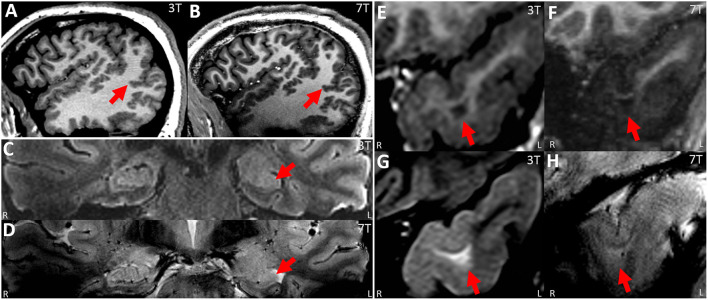
(A,B) Paired 3T−7T Images from a patient with extensive PMG in the right temporo-parieto-occipital region, showing similar lesion presence, improved lesion conspicuity and improved boundary (especially at the posterior part of the lesion, as shown by arrow) as assessed by the neuroradiologist team. (A) Sagittal image from T1w MPRAGE at 3T. (B) Sagittal image from T1w MP2RAGE at 7T. (C,D) paired 3T−7T Images from a patient with histologically confirmed HS type I in the left hippocampus (pointed out by arrow). For this patient, lesion presence, conspicuity and boundary were scored to be similar by the neuroradiologist team. Although the internal structures within the hippocampus might be better visualized at 7T, this improvement was mitigated by the loss of signal in the immediately adjacent temporal lobe (therefore more artifacts were scored to be present by the team). (C) T2w coronal FLAIR at 3T; (D) T2*w coronal GRE from 7T at the same position. (E–H) Paired 3T−7T Images from a patient with histologically confirmed FCD type IIb in the left temporal pole. Lesion presence, conspicuity and boundary were scored to be better at 3T from the neuroradiologist team. (E,G) Coronal zoomed images from T1w MPRAGE/T2w FLAIR sequences from 3T showing the lesion. (F,H) coronal zoomed images from T1w MP2RAGE/T2*w GRE sequences from 7T at the same location.